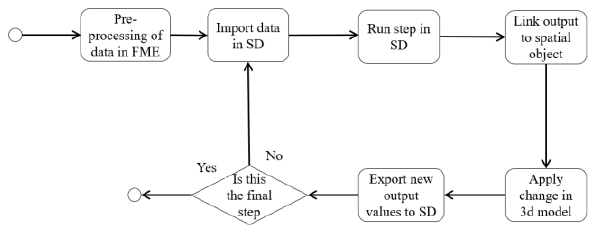
Figure 4: Diagram showing the interaction between Vensim and FME software package